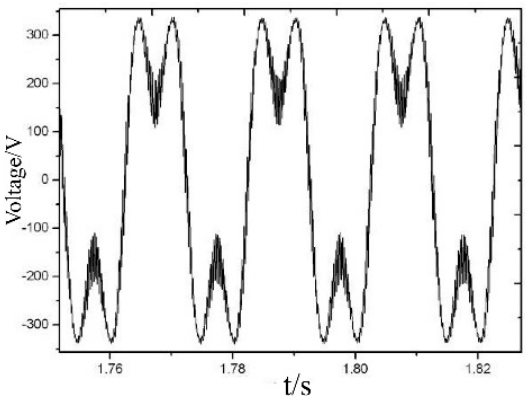
Figure 19. Waveform with third harmonic injection.